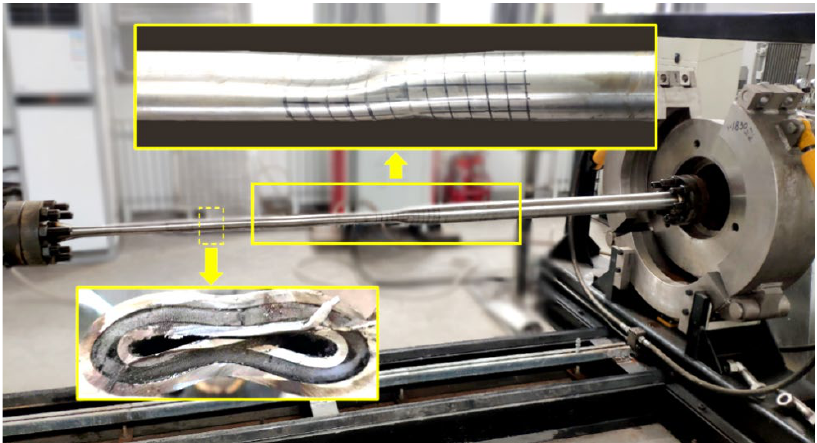
Figure 7. Photos after the sandwich pipes collapse.